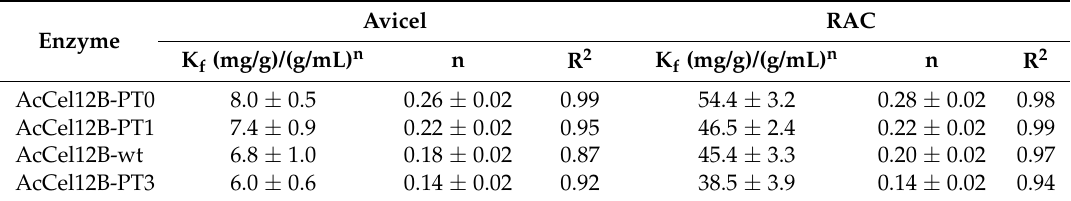
Table 5. Fitting curve parameters for desorption of AcCel12B and its mutants. Avicel RAC Enzyme K f (mg/g)/(g/mL) n